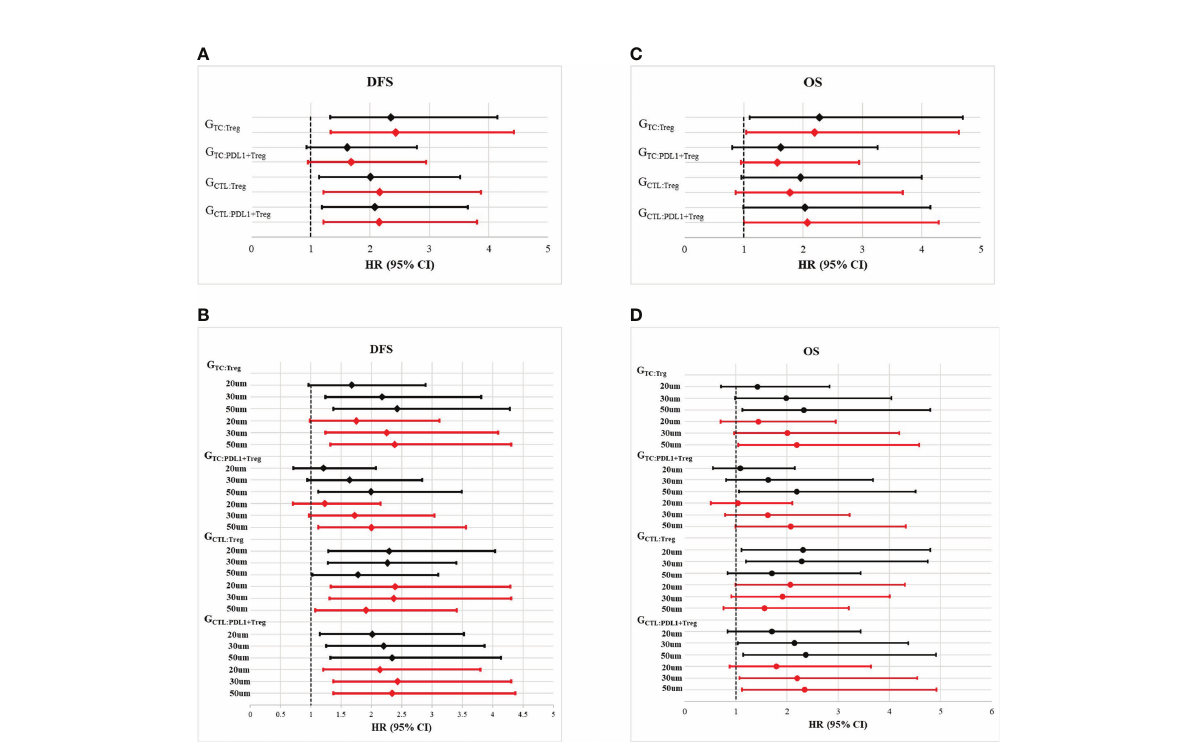
FIGURE 4 Forest plots of multivariate analysis and univariate analysis of Gcross function score in the whole cohort. (A) Hazard ratio of univariate (black solid line) and multivariate (red solid line) analysis of G TC : Treg , G TC : PDL1+Treg , G CTL : Treg and G CTL : PDL1+Treg for disease free survival (DFS). (B) Hazard ratio of univariate (black solid line) and multivariate (red solid line) analysis of G TC : Treg , G TC : PDL1+Treg , G CTL : Treg and G CTL : PDL1+Treg within certain raidus (20um, 30um and 50um) for disease free survival (DFS). (C) Hazard ratio of univariate (black solid line) and multivariate (red solid line) analysis of G TC : Treg , G TC : PDL1+Treg , G CTL : Treg and G CTL : PDL1+Treg for overall survival (OS). (D) Hazard ratio of univariate (black solid line) and multivariate (red solid line) analysis of G TC : Treg , G TC : PDL1+Treg , G CTL : Treg and G CTL : PDL1+Treg within certain raidus (20um, 30um and 50um) for overall survival